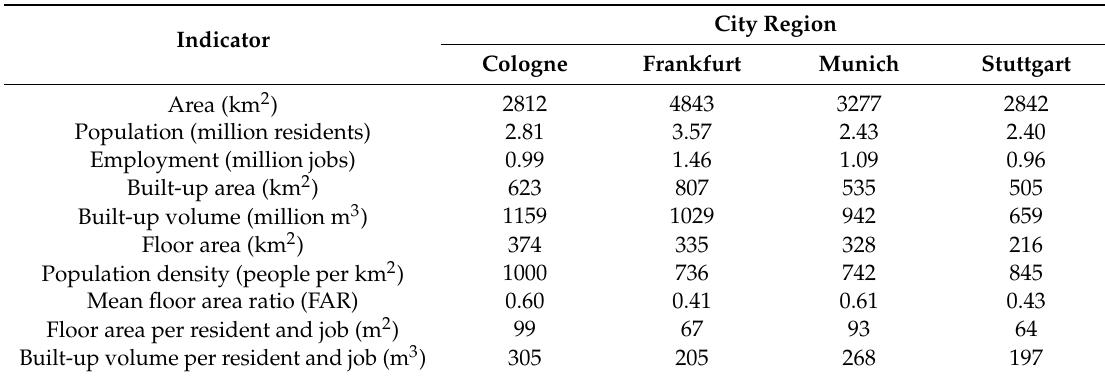
Table 2. Overview of spatial